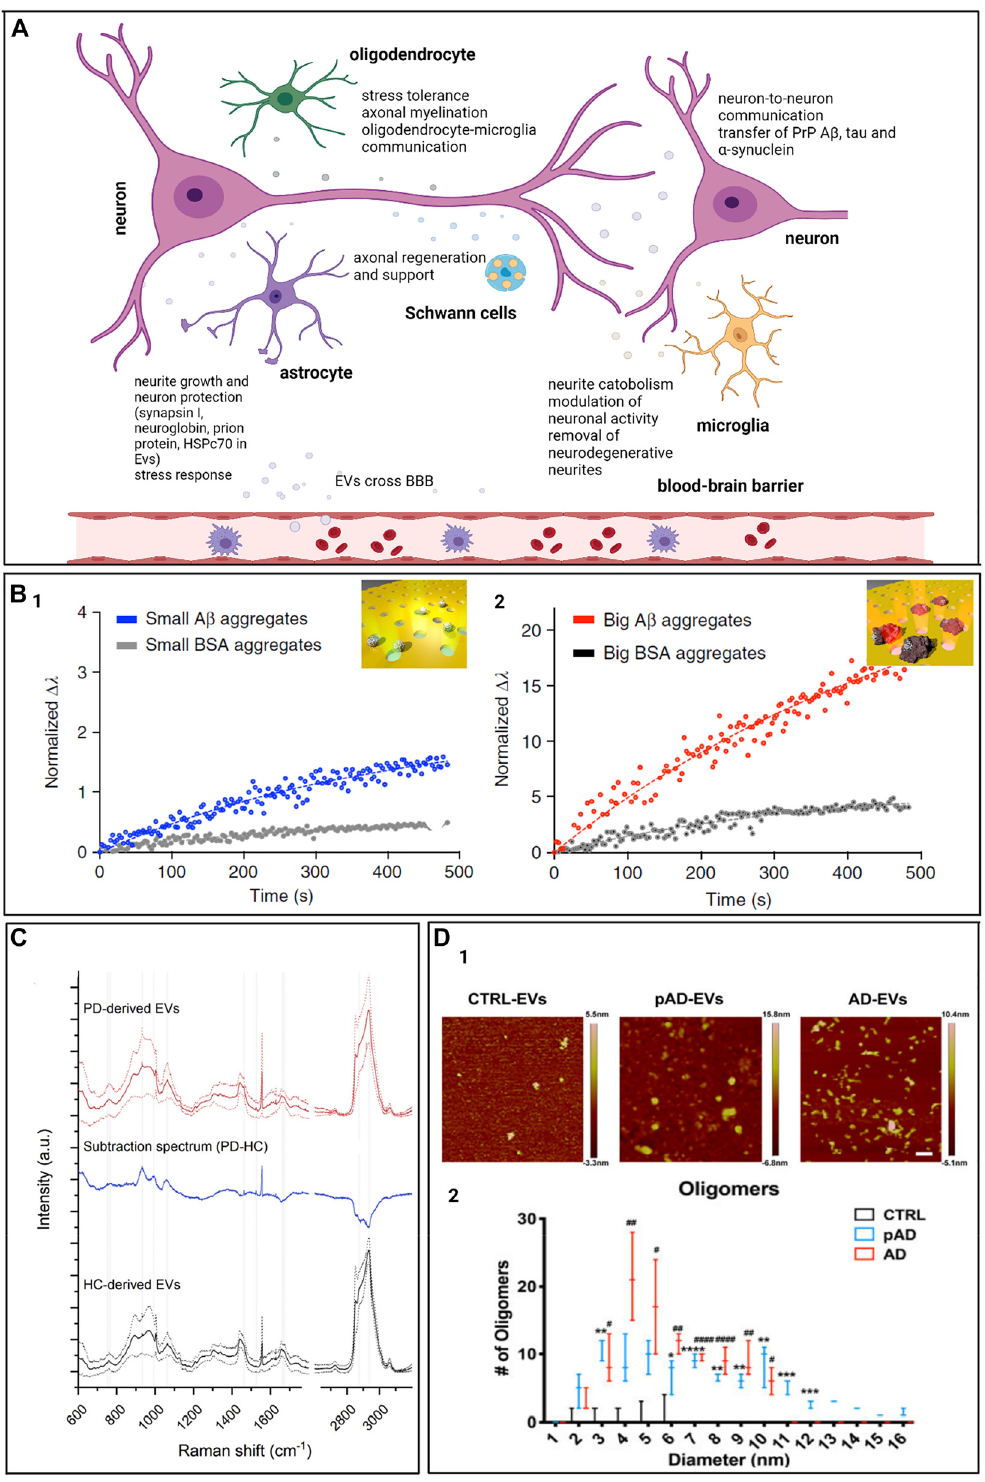
Figure 6: Application of label-free optical methods for characterization of EVs isolated from patients with neurological disorders. (A) Schematic of EVs based intercellular communication in CNS. (B) APEX platform for exosome associated A β detection. SPR sensograms showing exosome binding kinetics to (B1) small and (B2) large A β aggregates as well as to control bovine serum albumin (BSA) aggregates (adaptedwithpermissionfrom[250]).(C)Ramanspectroscopy-basedcharacterizationofEVsfordetectionofpatientswithPD.AverageRaman spectra of PD patients ’ serum derived EVs (red spectra) and EVs isolated from the serum of healthy individuals (black spectra). The